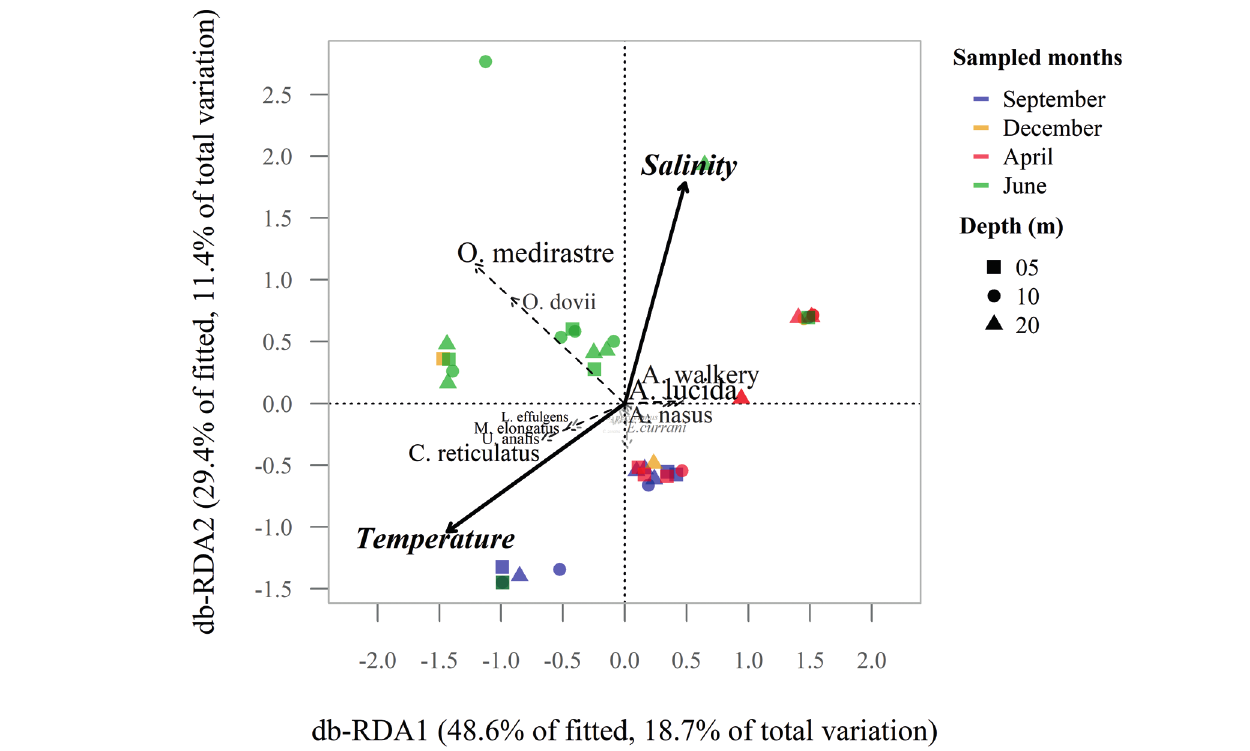
FIGURE 5 | Correlation triplot of the db-RDA showing the relationship between explanatory (temperature and salinity) and response variables (species). Black labels indicate the position of species in the ordination; their size increase according to the abundance of the species to achieve a better visualization. Samples are coded by depths and months. The angles between species and explanatory variables reflect their correlations; a small angle implies a positive correlation, a large one suggests a negative correlation, and a 90° angle indicates no correlation between two